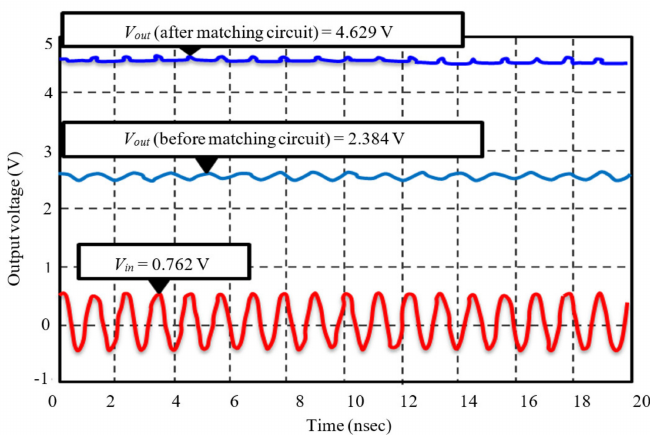
Figure 12. Output voltage of Cockcroft-Walton voltage multiplier circuit.